Question: Is the quantity shown trending increasing or decreasing?
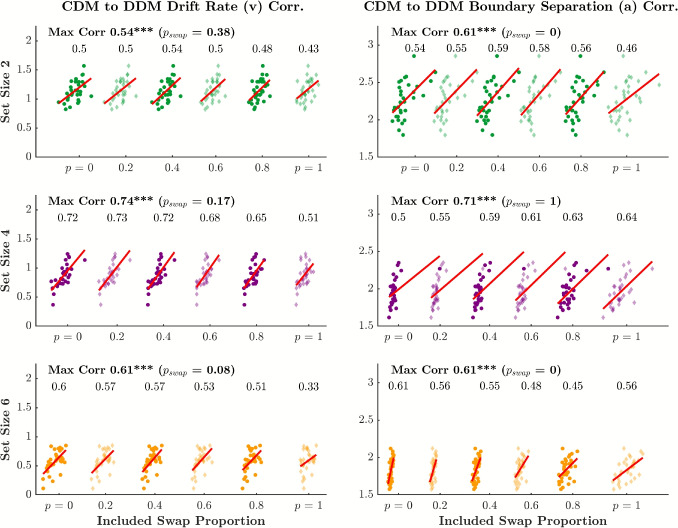
Answer: increasing